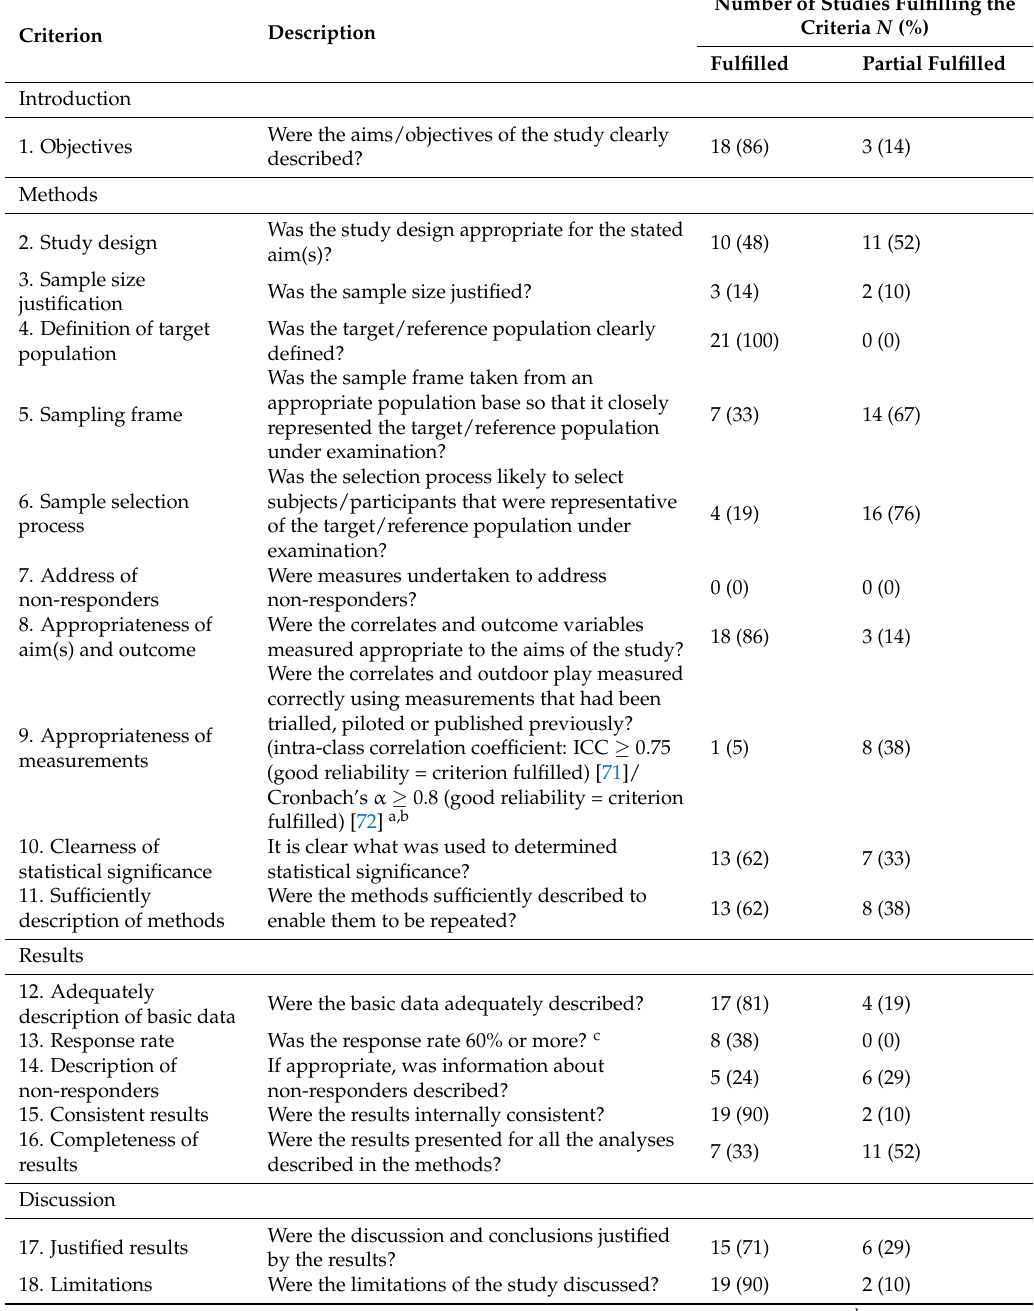
Table 2. Criteria for quality assessment and number (%) of studies scoring points for each